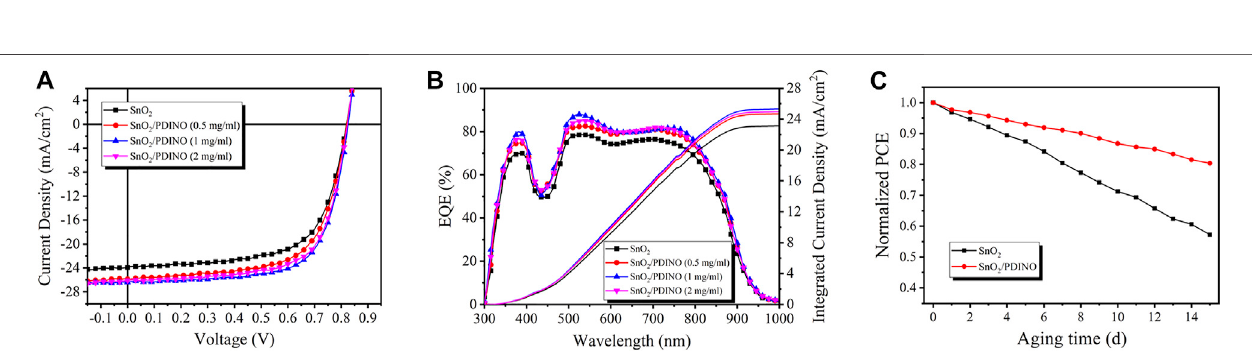
FIGURE4|(A) J – V curvesofOSCs. (B) EQE spectraandJEQEcurvesofOSCs. (C) NormalizedPCEsofOSCs after15 days ofaging.Thedeviceswerestoredin the air at room temperature ( ∼ 20 ° C) and without encapsulation.